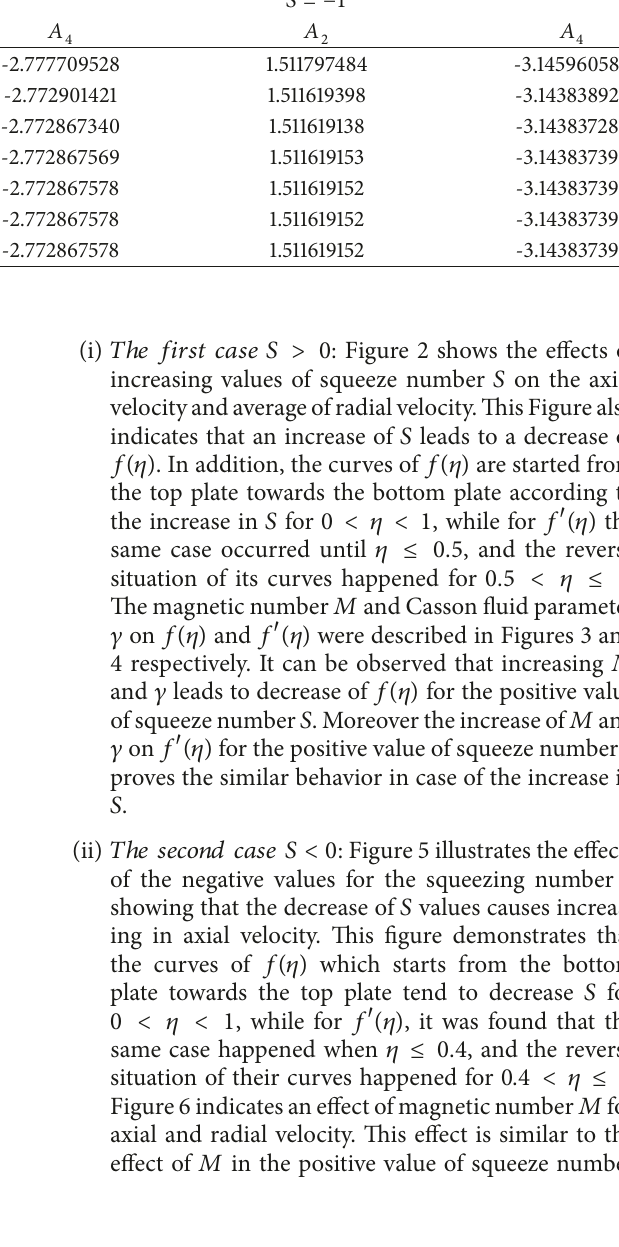
Table 3: Convergence of analytical-approximate solution for 𝑀 = 1 and 𝛾 = 0.2 .